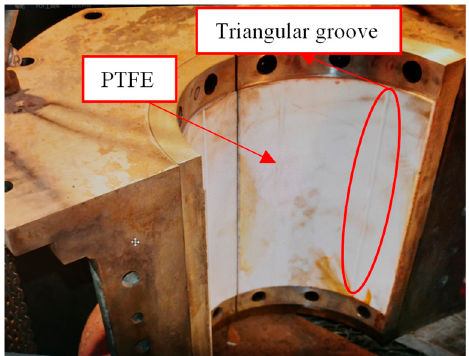
Figure 1. Water-lubricated hydrodynamic journal bearing coated with PTFE.